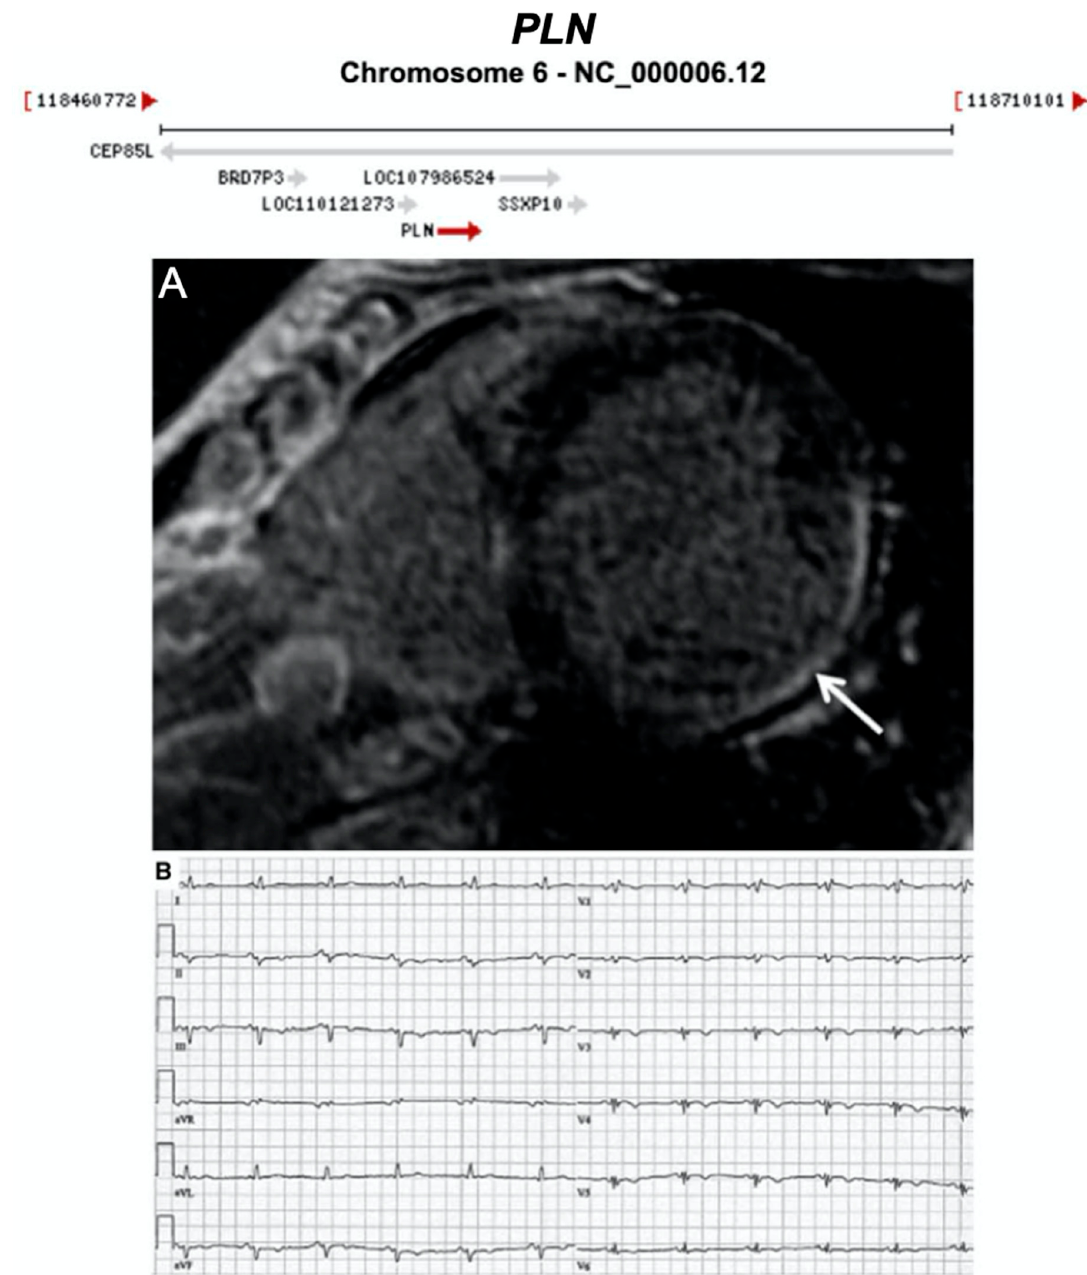
Figure 16. Exemplar MRI and ECG finding found in ACM patients with PLN mutations. ( A ) CMR image from a patient with PLN p.Arg14del mutation showing inferolateral wall thinning and late-gadolinium enhancement of the LV inferolateral wall; ( B ) 12-lead ECG of the same patient showing normal sinus rhythm with low voltages in all leads ( < 0.5mV) and flattened or inverted T-waves in V1-V6 and inferior leads (II, III, aVF). Reproduced with permission from te Rijdt et al. (2019)